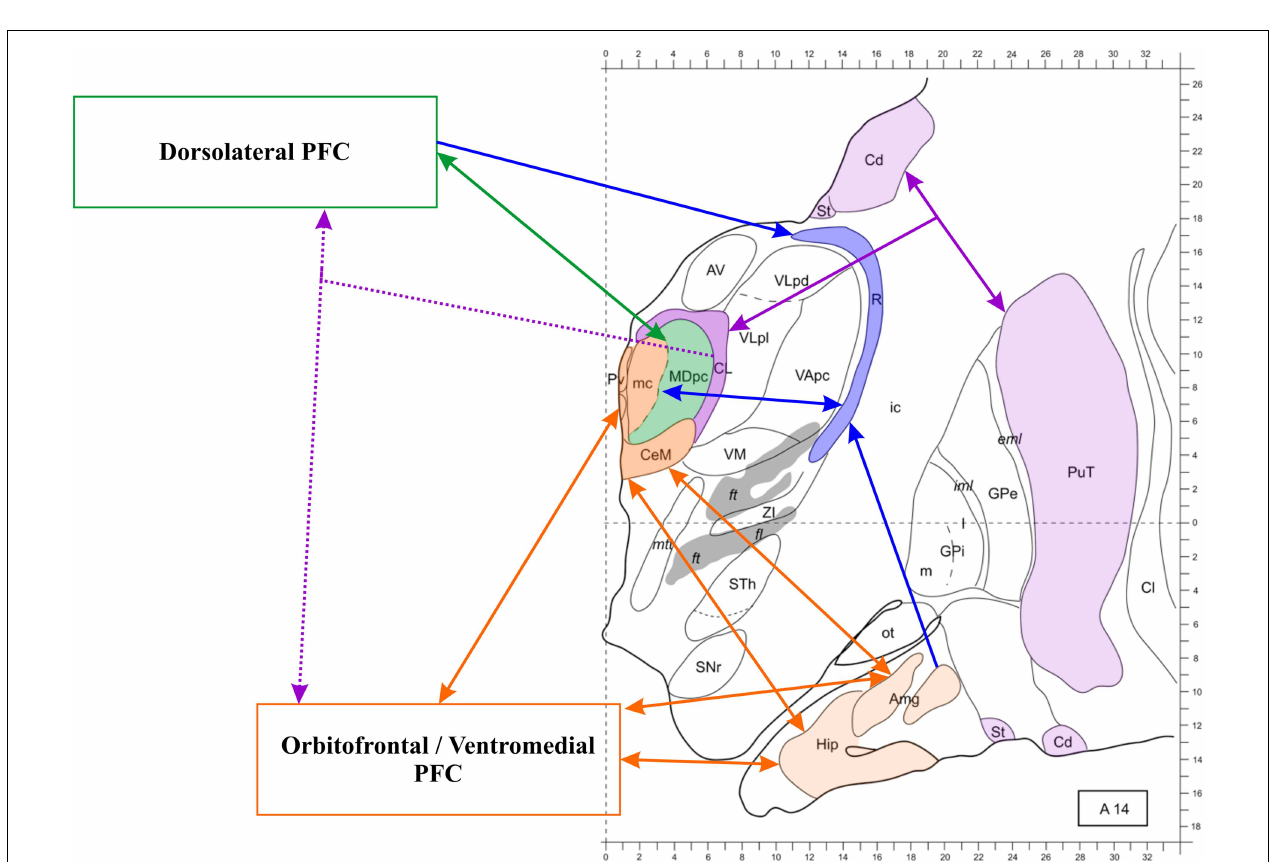
centrolateral nucleus (CL) is represented in this section) are part of the thalamo-striato-frontal network (striato-frontal connections are not represented). Modified from Morel (2007). Abbreviations: Amg, amygdala; AV, anteroventral nucleus; Cd, caudate nucleus; Cl, claustrum; eml, external medullary lamina; ft, fasciculus thalamicus; ic, internal capsula; iml, internal medullary lamina; GPe, globus pallidum, pars externa; GPi, globus pallidum, pars interna; Hip, hippocampus; MDpc, parvocellular MD; mc, magnocellular MD; mtt, mammillothalamic tract; ot, olfactory tubercle; PuT, putamen; Pv, paraventricular nucleus; SNr, substantia nigra, pars reticulate; St, striatum; STh, subthalamic nucleus;VApc, ventral anterior nucleus, parvocellular portion;VLpd, ventrolateral nucleus, posterior dorsal subunit;VLpl, posterior lateral subunit;VM, ventromedial nucleus; ZI, zona